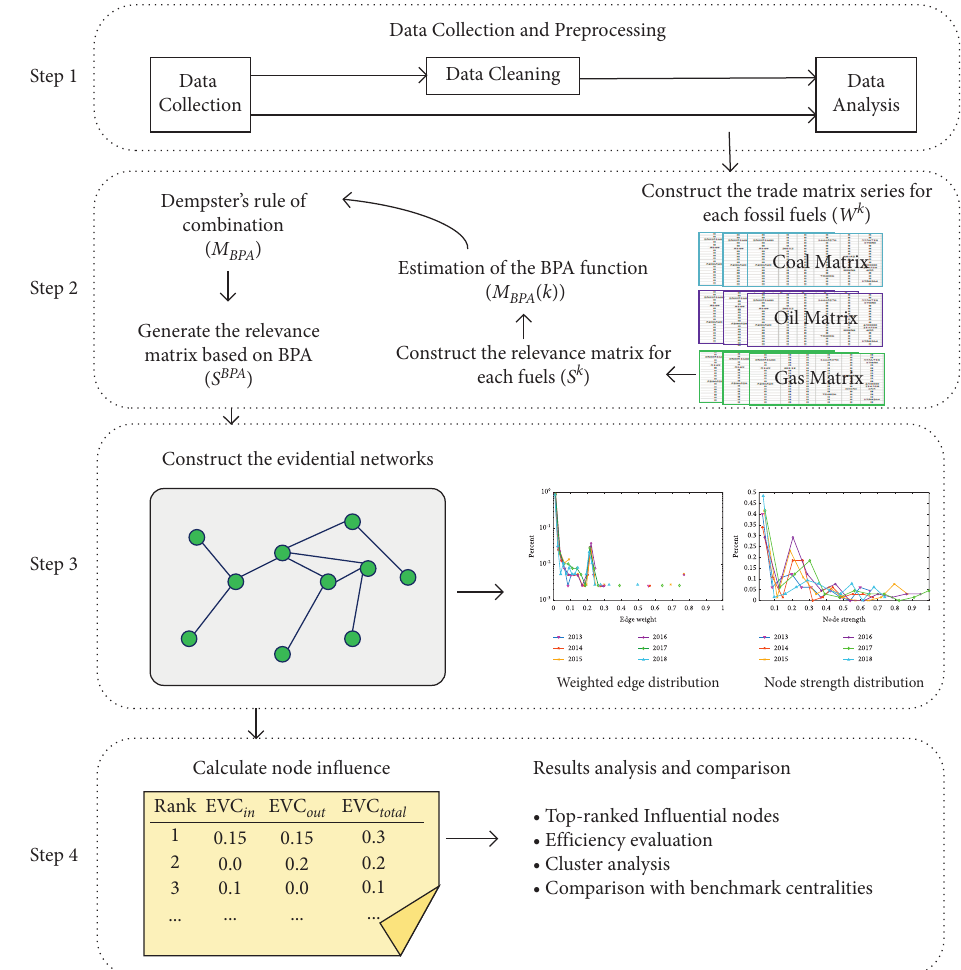
Figure 2: Flowchart of the proposed D-S based network